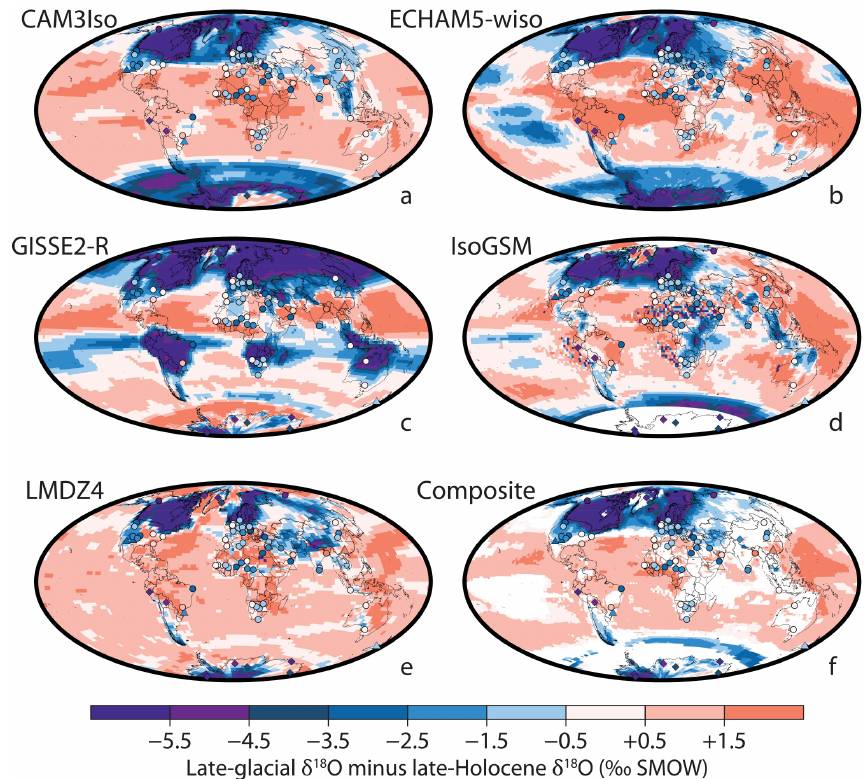
Figure 5. Simulated precipitation δ 18 O differences between the last glacial maximum and pre-industrial time periods (i.e., δ 18 O last glacial maximum – δ 18 O pre-industrial ) from five general circulation models: CAM3iso, ECHAM5-wiso, GISSE2-R, IsoGSM and LMDZ4 (Yoshimura et al., 2003; Legrande and Schmidt, 2008, 2009; Risi et al., 2010a; Noone and Sturm, 2010; Pausata et al., 2011a; Werner et al., 2011). Circles (groundwater), triangles (speleothems) and diamonds (ice cores) show measured (cid:49) 18 O late-glacial values from paleoclimate proxy records (Fig. 1, original data presented in Tables S2–S5). The panel entitled “Composite” shows the multi-model ensem- ble median simulated (cid:49) 18 O late-glacial value where at least four of the five models agree on the sign of simulated (cid:49) 18 O late-glacial values (i.e., positive or negative; all five model simulations of δ 18 O last glacial maximum – δ 18 O pre-industrial were used to calculate multi-model median shown in